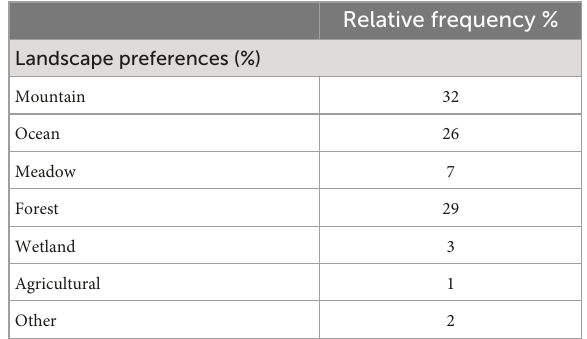
TABLE 3 Descriptive results from PwMDs demographic population characteristics data